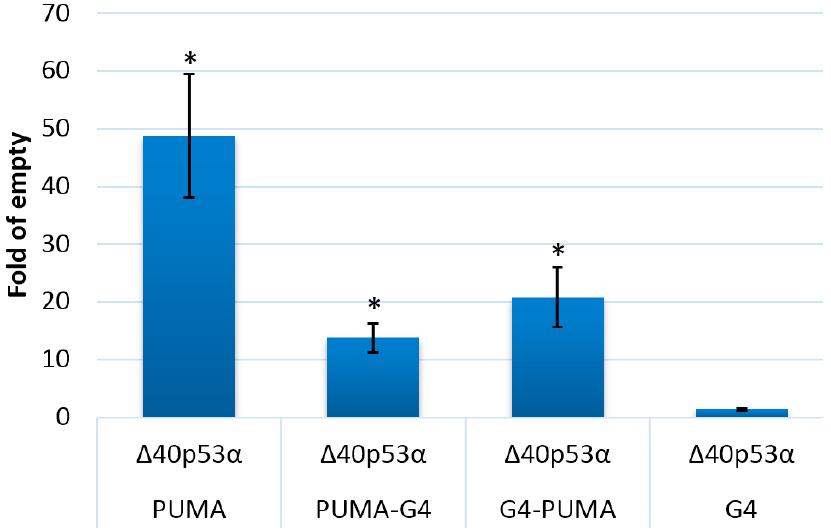
Figure 6. Impact of the G4 prone sequence on Δ 40p53 α transactivation activity from the PUMA RE. Δ 40p53 α was expressed under an inducible GAL1 promoter. Histograms show average fold induction over empty vector in three biological replicates (mean ± S.D.). The results obtained after 24 h in 2% galactose inducing media are presented. Asterisks indicate a significant induction of p53-dependent transactivation ( p < 0.05).